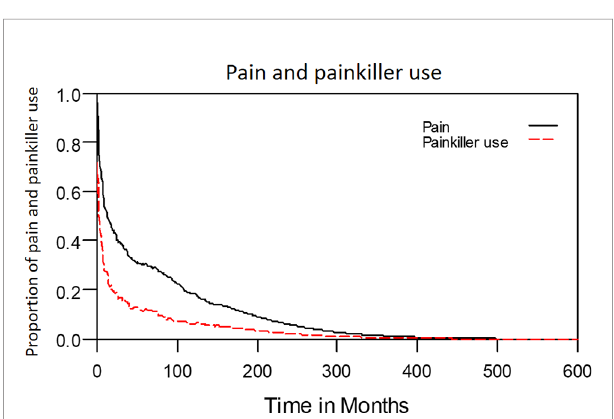
FIGURE 4 | Dynamic changes in pain and painkiller use in patients with locally advanced OSCC.